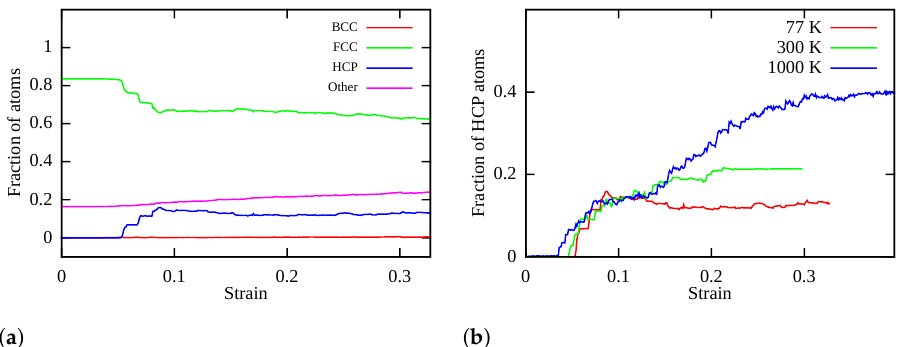
Figure 8. ( a ) Change in fraction of atoms during tensile deformation of CoNiCrFeMn HEA nanowire at 77 K; ( b ) fraction of HCP atoms during tensile deformation of CoNiCrFeMn HEA NW at 77 K, 300 K, and 1000